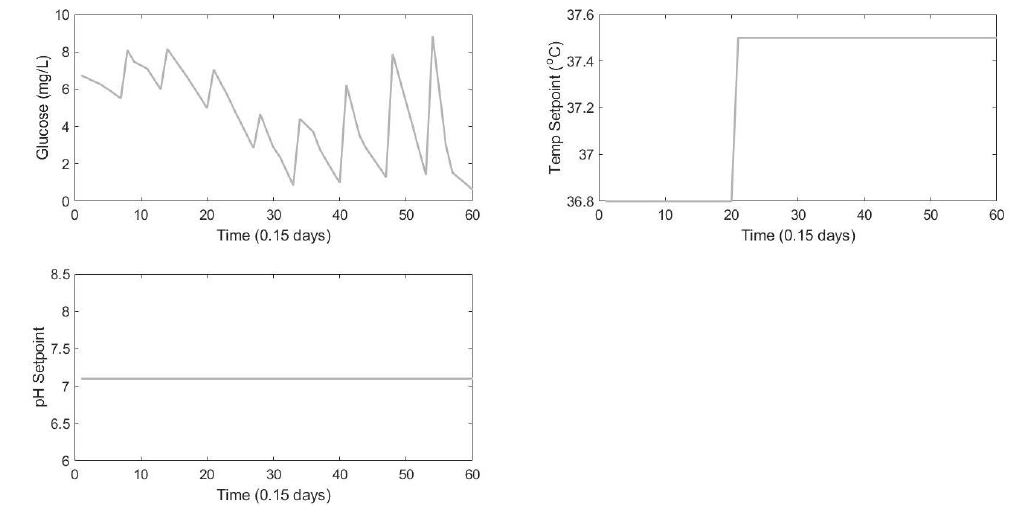
Figure 3. The input profiles for a training